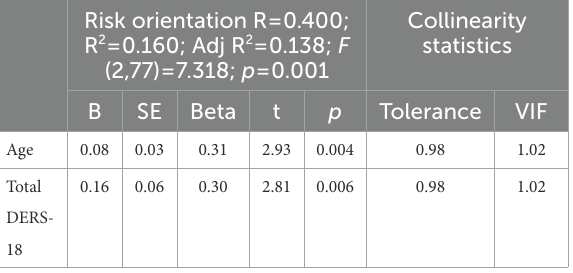
TABLE 4A Multiple regression model performed on risk orientation with age and emotional dysregulation’s total score (Total DERS-18) as independent variables.